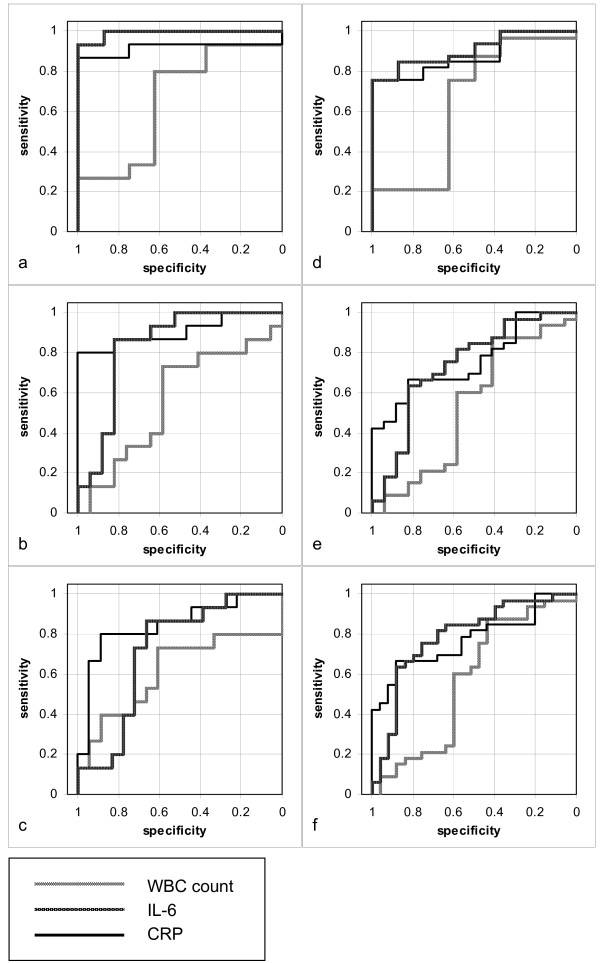
ROC curves for WBC count, CRP, and IL-6. Curves a) represent discrimination between NSAP (group 1) and perforative appendicitis (group 4), b) group 1 and cases requiring immediate surgery (groups 3 and 4), c) early appendicitis (group 2) and group 4, d) group 2 and groups 3 and 4, e) phlegmoneous (group 3) und perforative (group 4) appendicitis, and f) cases not requiring immediate surgery (groups 1 and 2) against groups 3 and 4.